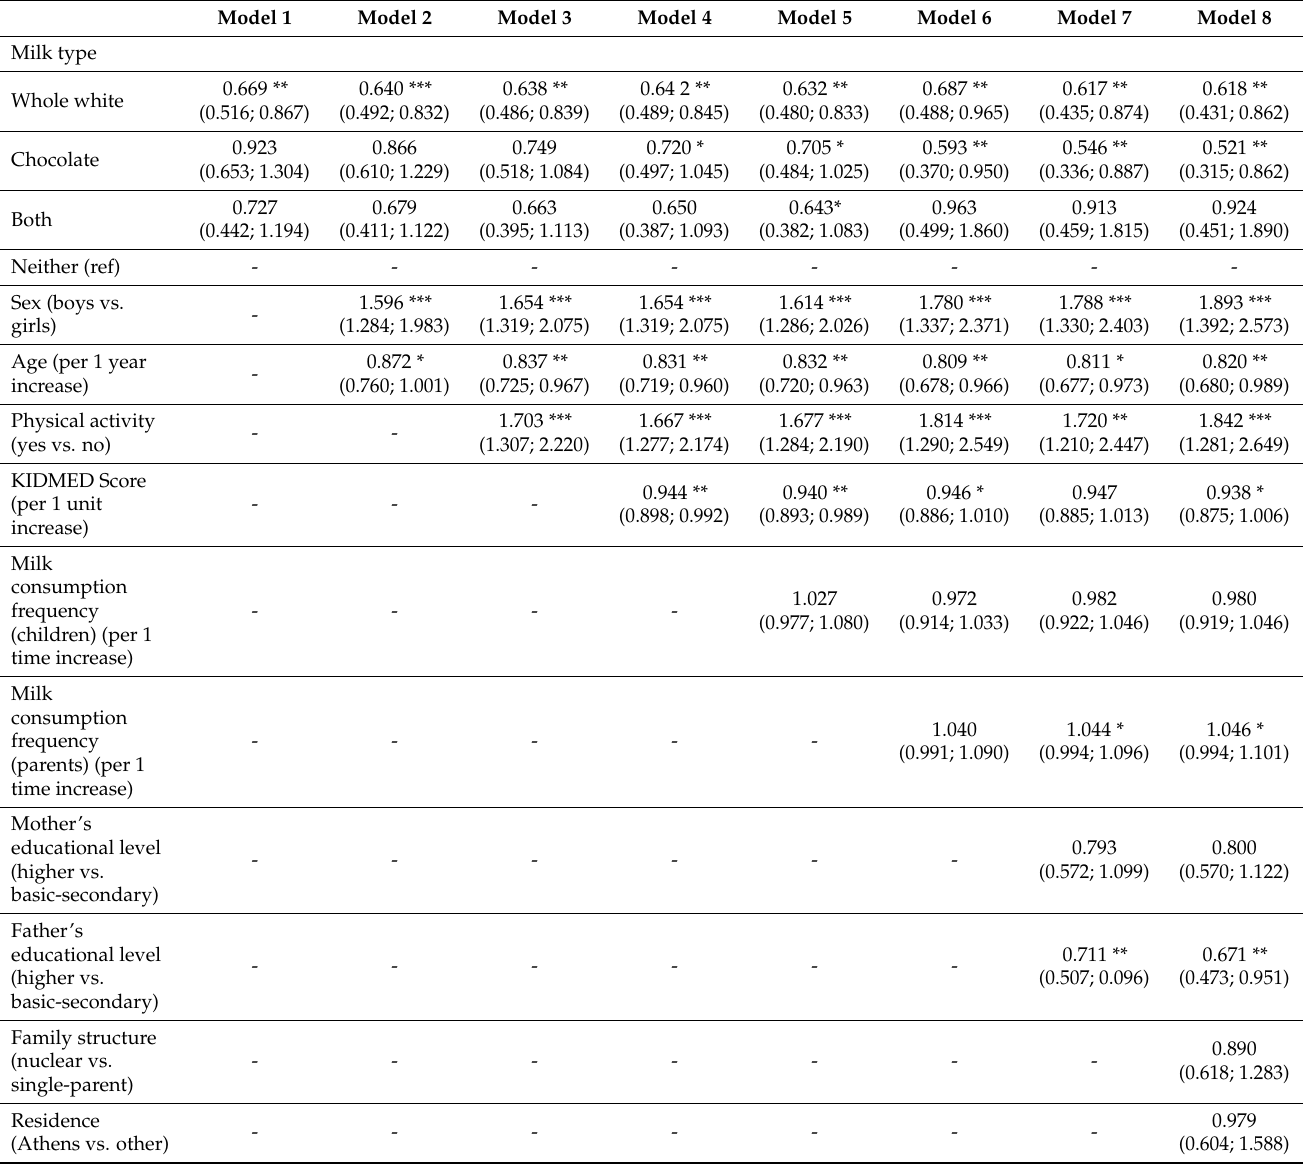
Table 5. The association between milk consumption and children’s weight status category (over- weight/obesity vs. normal), adjusted for several characteristics through nested logistic regression models (OR, 95%